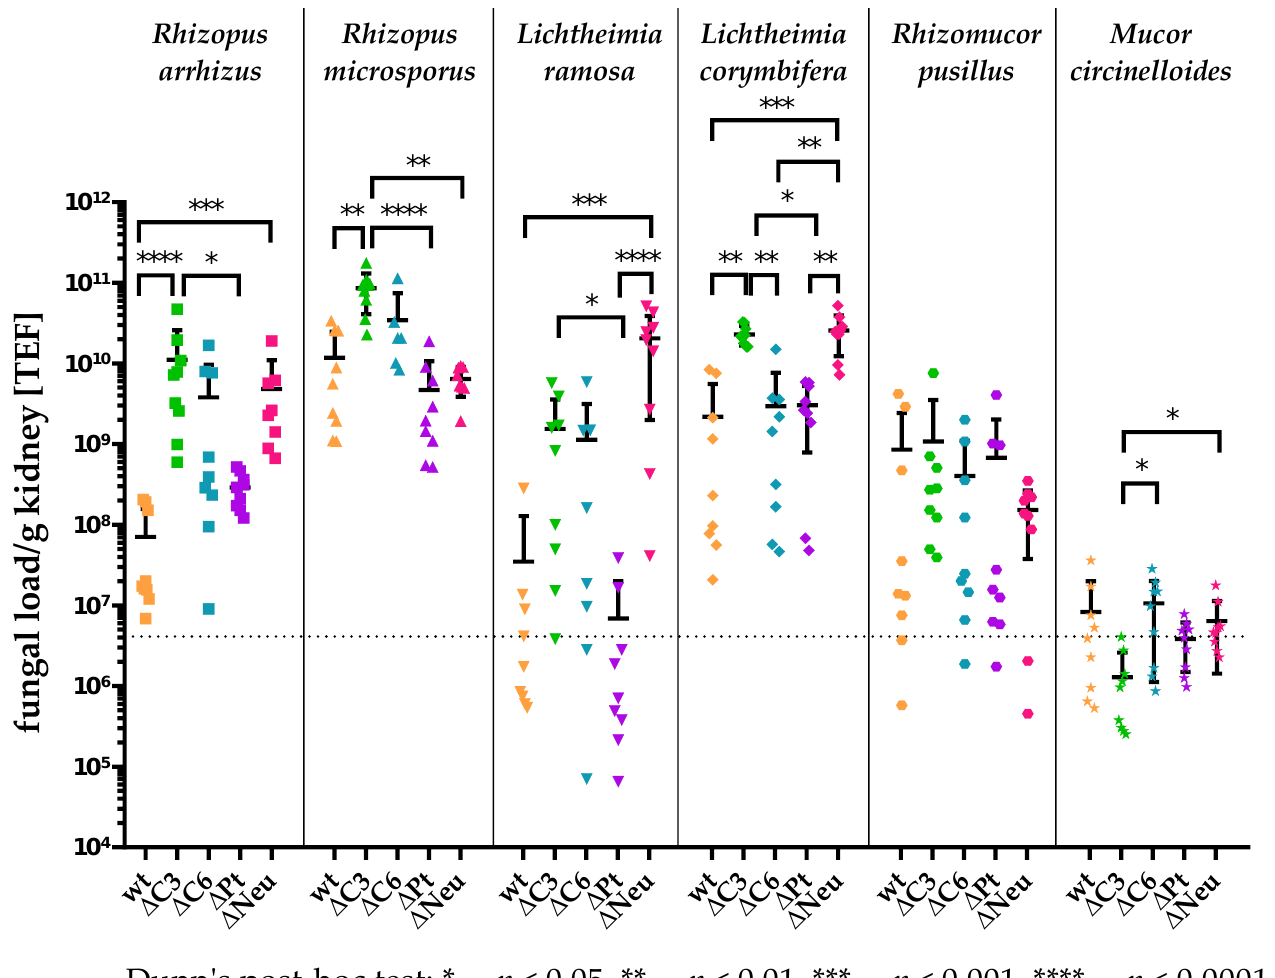
Figure 5. Fungal load per gram kidney tissue. Immunocompetent (wt, n = 9), C3-deficient ( Δ C3, n = 9), C6-deficient ( Δ C6, n = 9), thrombocytopenic ( Δ Pt, n = 9), and neutropenic ( Δ Neu, n = 9) animals were intravenously challenged with 5 × 10 5 spores of R. arrhizus , R. microsporus , L. ramosa , L. corymbifera , Rh. pusillus , or M. circinelloides . Fungal load in the kidney was quantified by PCR based on the translation elongation factor (TEF) of mucormycetes at the day of exitus. Asterisks (*) indicate the level of significance for an adjusted p -value, comparing pairs of groups within a fungal species using a Dunn’s post hoc test after the Kruskal – Wallis test reported significance.